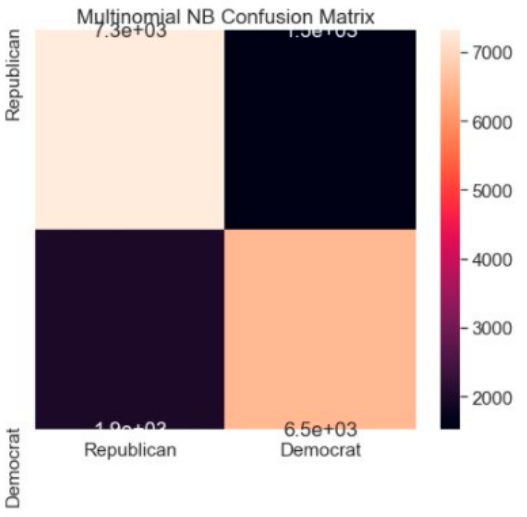
Figure 14. Confusion Matrix for Multinomial NB.